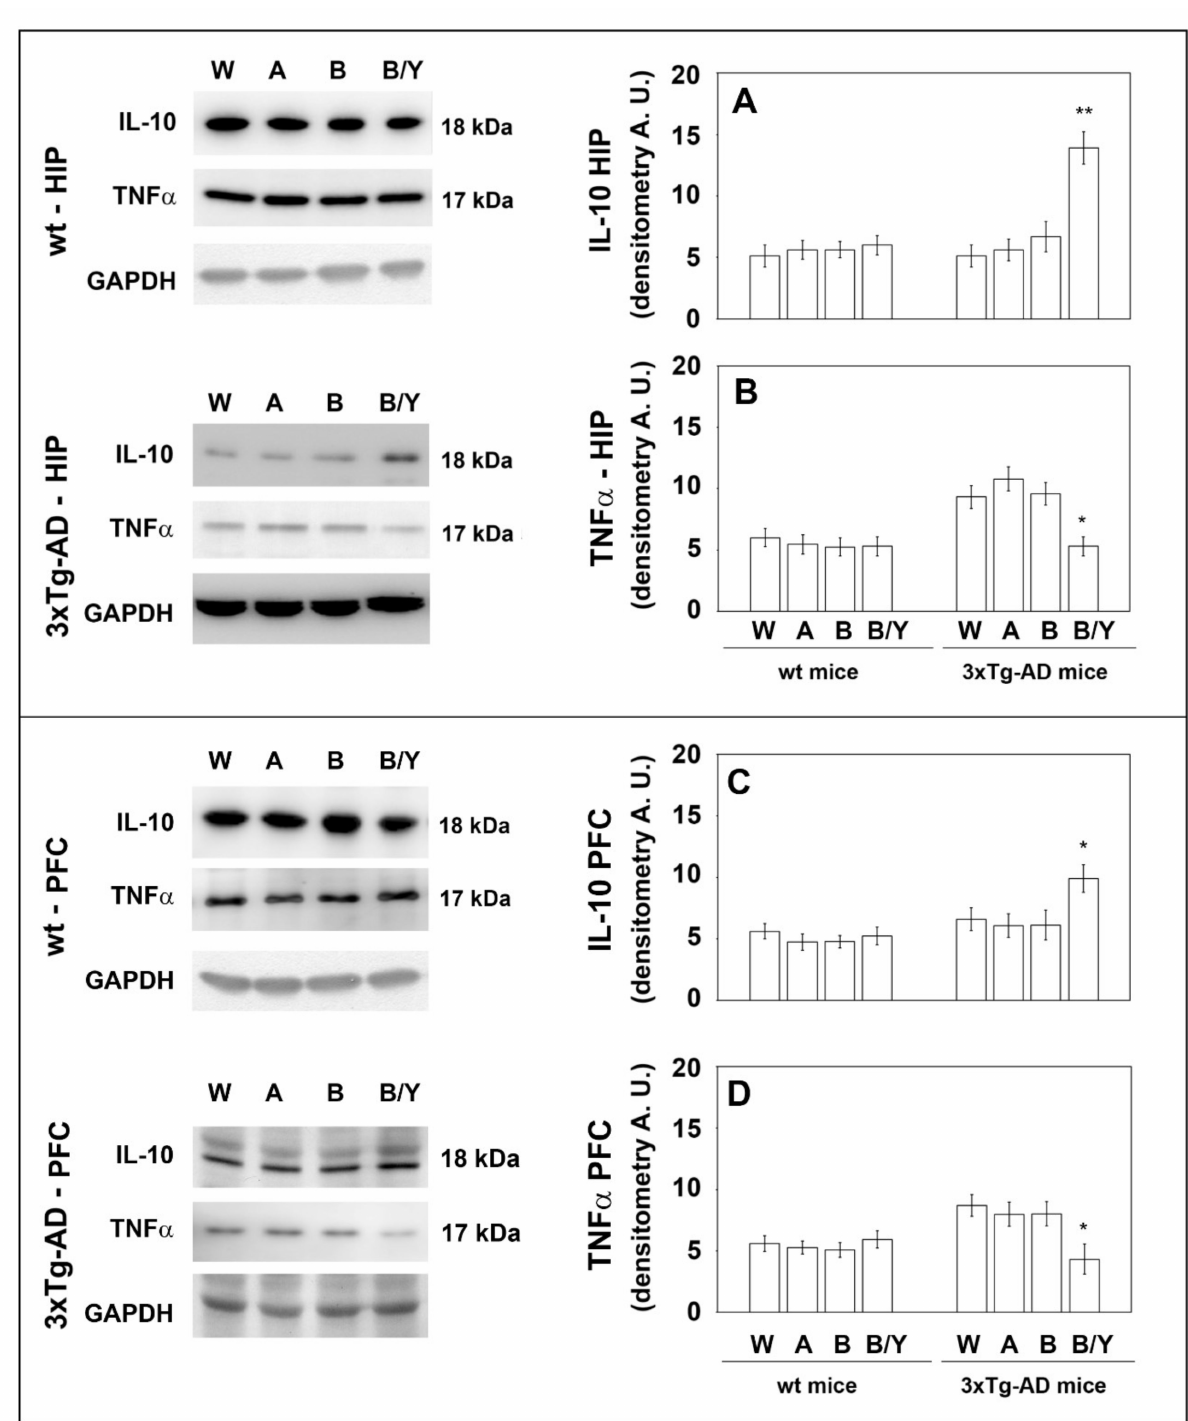
Figure 5. Levels of TNF- α and IL-10 measured by WB on brain samples of the wt and 3xTg-AD mice treated with water, alcohol, beer and beer/yeast. IL-10 expression increased in the HIP and PFC of 3xTg-AD mice (panels A – C ), whereas TNF- α expression decreased in the tested brain regions (panels B – D ). Representative immunoblots and densitometric analyses are shown (A.U.: arbitrary units). Equal protein loading was verified using an anti-GAPDH antibody. HIP: hippocampus; PFC: prefrontal cortex. Data points marked with an asterisk were statistically significant compared to the respective untreated cell line (* p < 0.05; ** p < 0.01, B/Y vs. W, A and